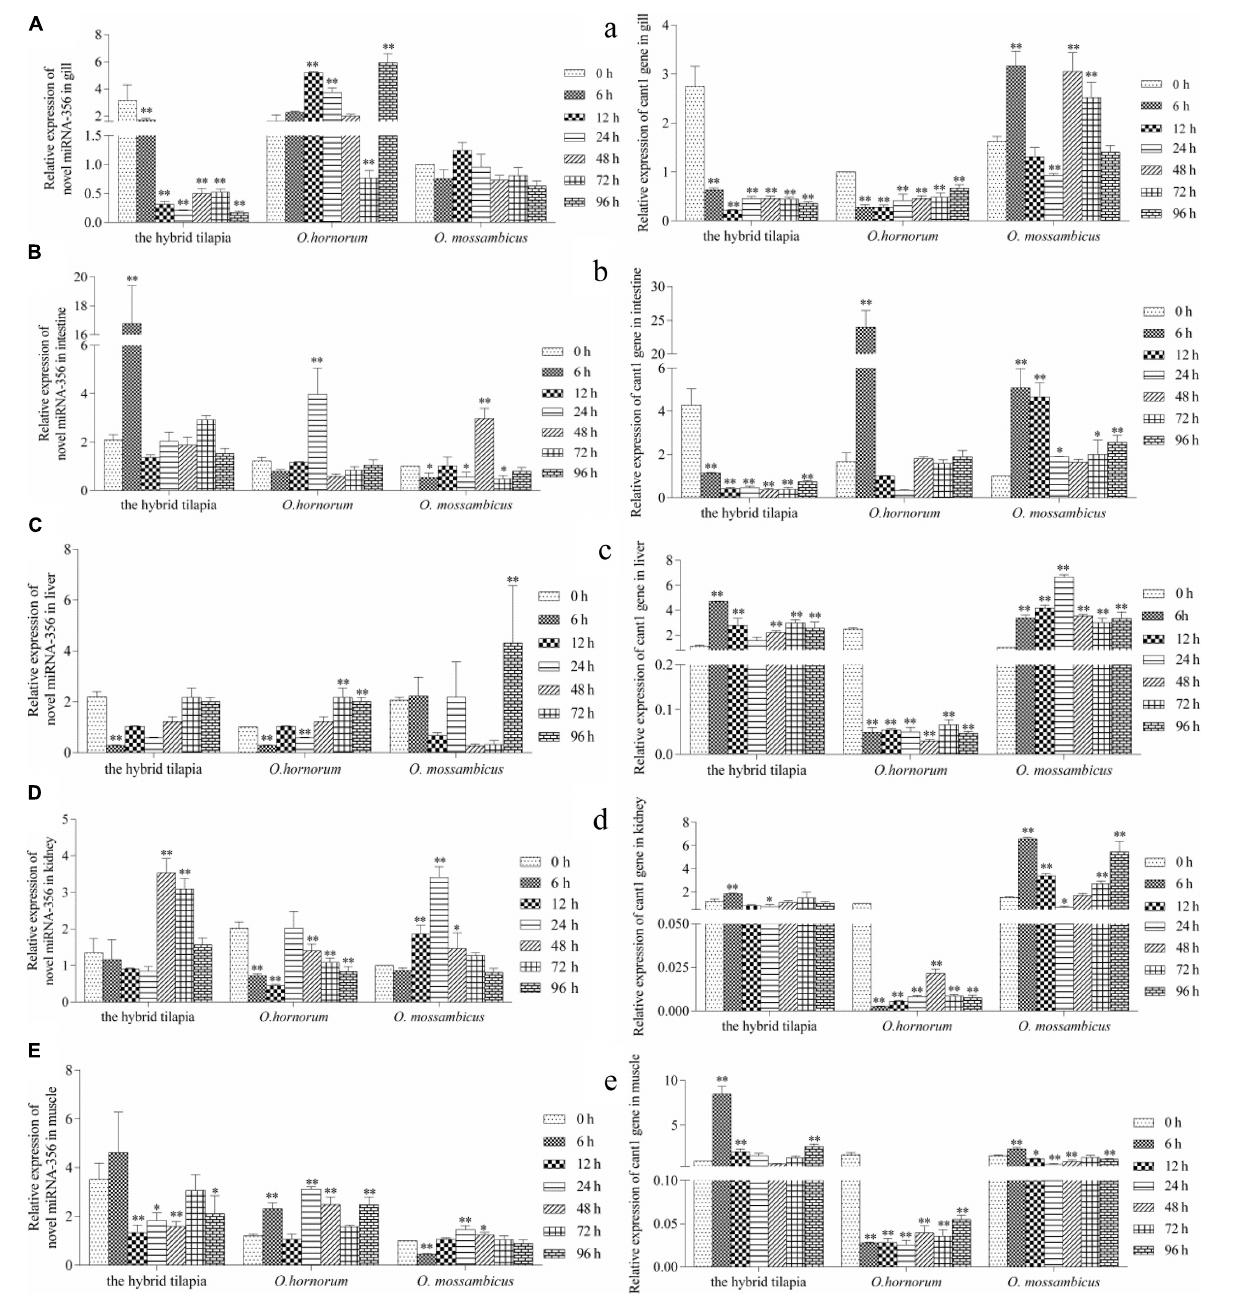
FIGURE 6 | Expression levels of selected novel miRNA-356 (A–E) and its target gene cant1 (a–e) in the control group (C group) and alkalinity stressed group (A group) in the hybrid tilapia and its parent samples for 96h. “ ∗ ” and “ ∗∗ ” indicate significant differences ( P < 0.05 and P < 0.01, respectively) between values obtained pre-(0 h) and post-alkali stress (6, 12, 24, 48, 72, and 96 h), by paired-samples t